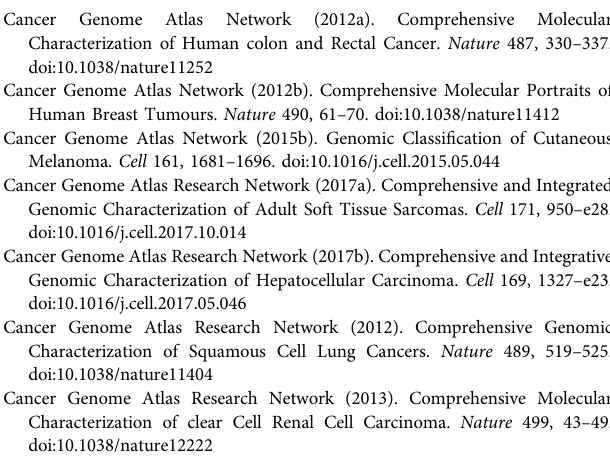
Supplementary Table S3 | Mutation prevalences for pathway and gene analysis. Supplementary Table S4 | Correlation analysis of allele frequency with mutation score for TP53 and KRAS . Supplementary Table S5 | Excel File for all AUROC combined Pathway and Genes. Supplementary Table S6 | Prediction results for all tumor types with all statistics. AUROC_avg, average area under the receiver operating curve (AUROC); AUROC_low, lower bound of AUROC con fi dence interval (CI); AUROC_high, upper bound of AUROC CI; AUCPR_avg, average area under the